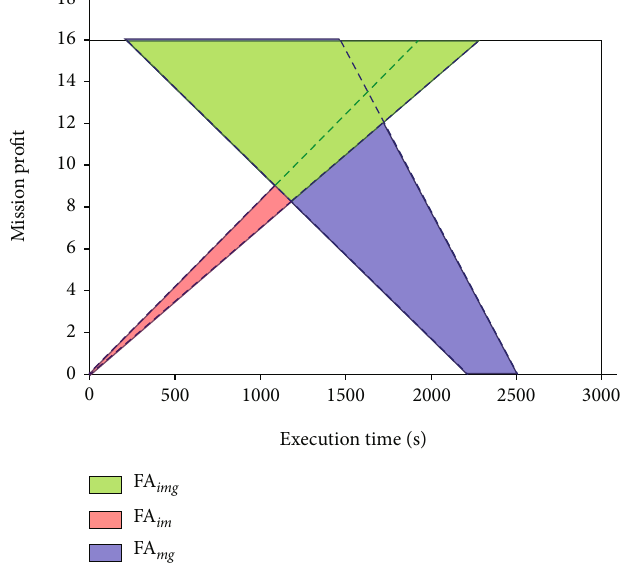
Figure 8: Three certain areas and three fuzzy